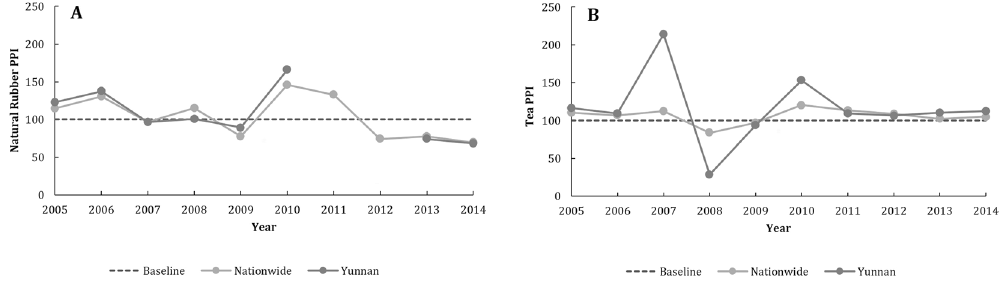
Figure 5. Annual Producer Price Index (PPI) for natural rubber and tea in Yunnan Province and nationwide during 2005 to 2014. ( A ) natural rubber PPI ( B ) tea PPI. Baseline: the price in the previous year is 100. (A Producer Price Index (PPI) measures the average changes in prices received by domestic producers for their output. In the US, the PPI was known as the Wholesale Price Index, or WPI, up to